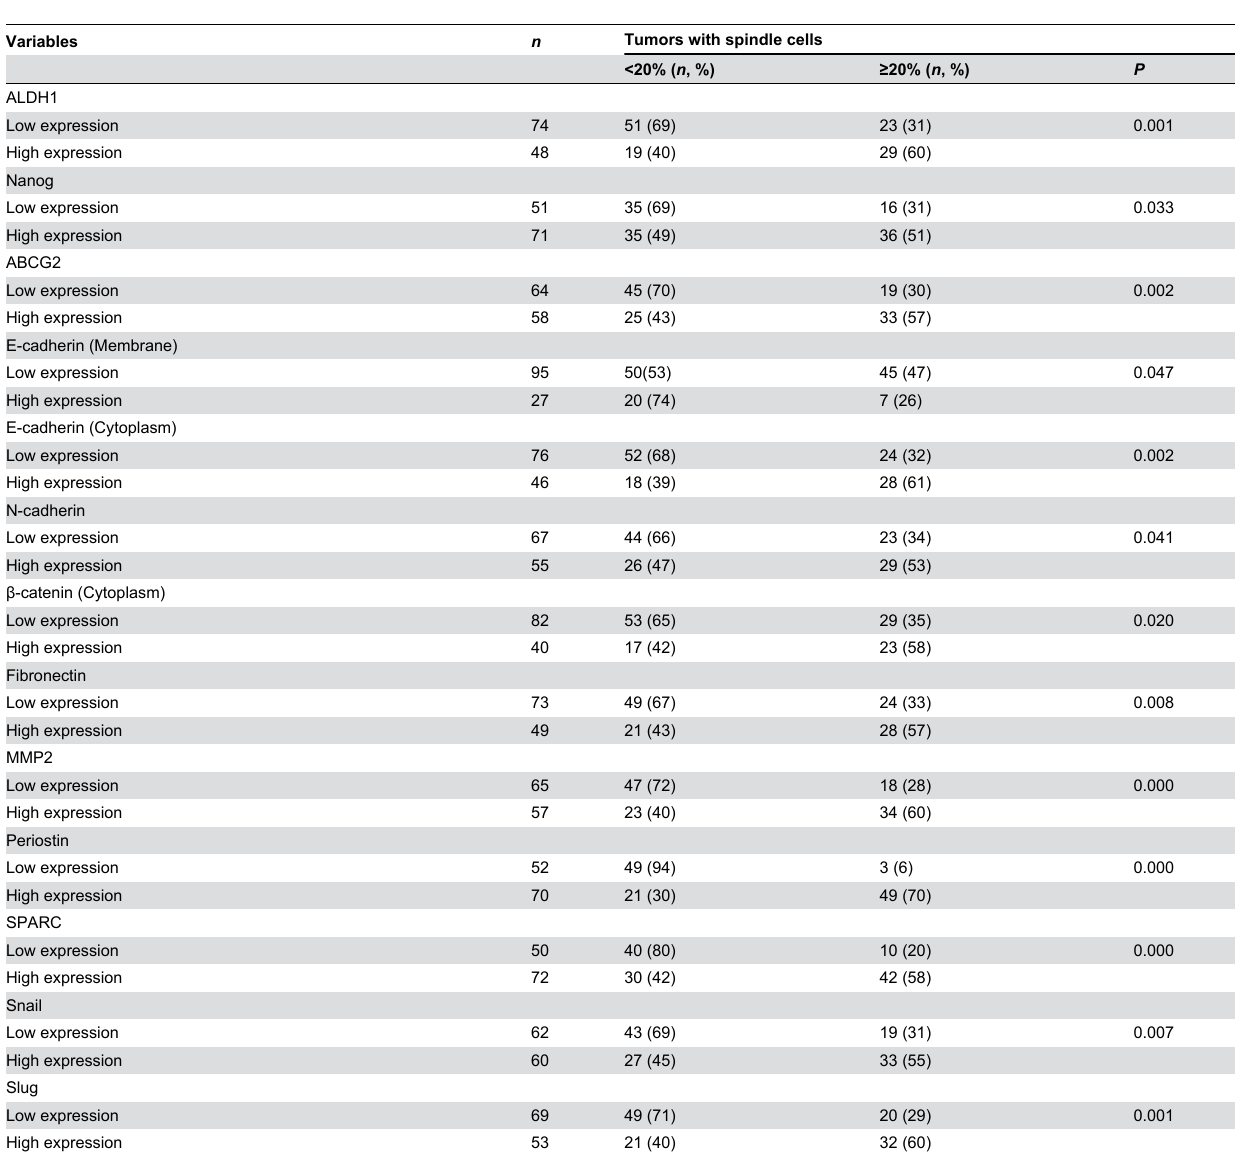
Table 1. The significant expression of CSCs and EMT biomarkers in 122 NPCs with neoplastic spindle cells.